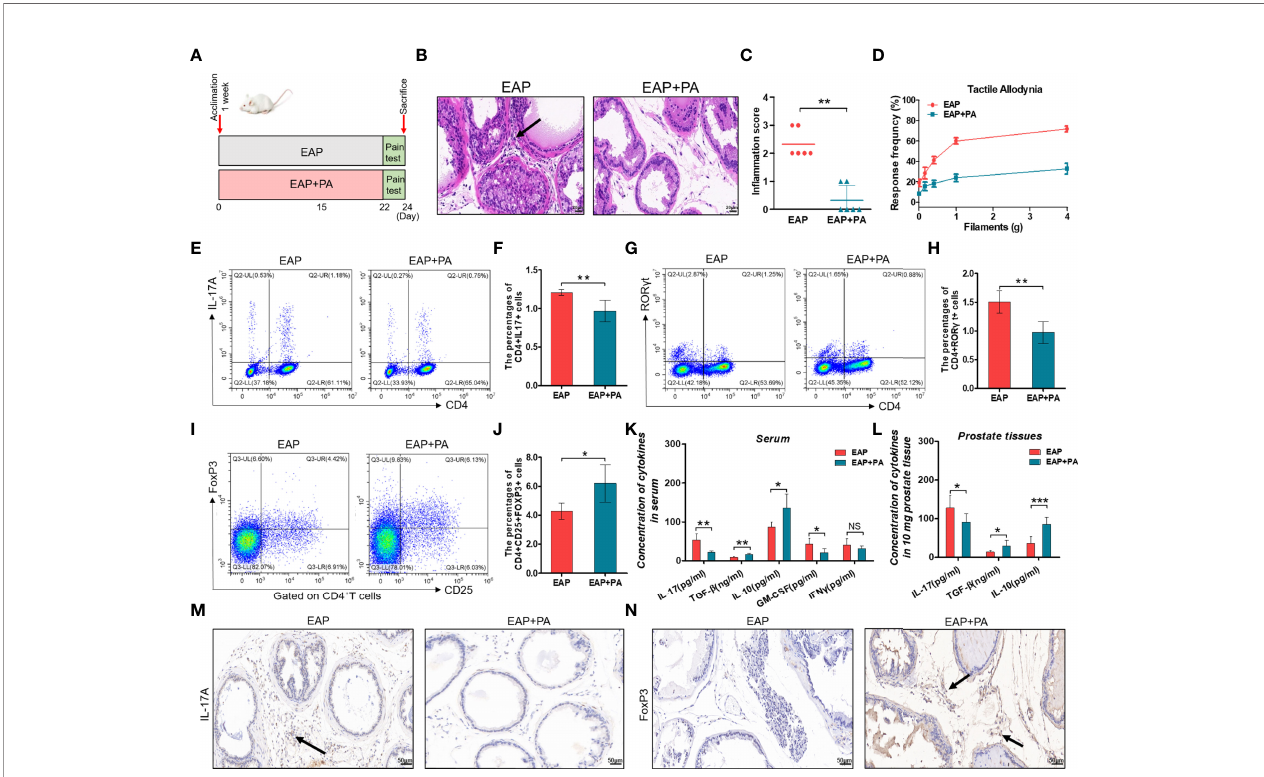
FIGURE 5 | Propionic acid ameliorates EAP and restores Th17/Treg imbalance in vivo. (A) After 1 week of acclimation, all mice received EAP induction. They were divided into an untreated group (EAP group) and a propionate-treated group (EAP+PA group) according to whether propionic acid was added in drinking water or not. Mice were sacri fi ced on day 24 and then samples were collected. (B) Representative HE staining of prostate sections from untreated and propionate-treated EAP mice. The black arrowhead indicates in fi ltration of in fl ammatory cells in the EAP group. (C) In fl ammation score of prostate sections from untreated and propionate-treated EAP mice. (D) Chronic pelvic pain measurement of untreated and propionate-treated EAP mice. (E) Representative pictures of fl ow cytometric staining for CD4 + IL-17 + cells in the splenic lymphocytes from untreated and propionate-treated EAP mice. (F) Flow cytometric analysis of the proportion of CD4 + IL- 17 + cells in untreated and propionate-treated EAP mice. (G) Representative pictures of fl ow cytometric staining for CD4 + ROR g t + cells in the splenic lymphocytes from untreated and propionate-treated EAP mice. (H) Flow cytometric analysis of the proportion of CD4 + ROR g t + cells in untreated and propionate-treated EAP mice. (I) Representative pictures of fl ow cytometric staining for CD4 + CD25 + FoxP3 + cells in the splenic lymphocytes from untreated and propionate-treated EAP mice. (J) Flow cytometric analysis of the proportion of CD4 + CD25 + FoxP3 + cells in untreated and propionate-treated EAP mice. (K) Detection of serum cytokine productions (IL-17, GM-CSF, IFN g , TGF- b , and IL-10) from untreated and propionate-treated EAP mice. (L) Concentration determination of IL-17, TGF- b , and IL-10 in 10 mg of prostate tissue in untreated and propionate-treated EAP mice. (M) Immunohistochemical staining of IL-17A (marker of Th17) on prostate sections in untreated and propionate-treated EAP mice. (N) Immunohistochemical staining of FoxP3 (marker of Treg) on prostate sections in untreated and propionate-treated EAP mice. The black arrows indicate the IL-17/FoxP3-positive cells in the two groups. Data are from one experiment representative of three independent experiments. Data are representative of three independent experiments. n = 5 – 6/group; * p < 0.05; ** p < 0.01; *** p < 0.001; NS, not signi fi cant; EAP, experimental autoimmune prostatitis; HE, hematoxylin – eosin, PA, propionic acid; IL-17, interleukin-17; ROR g t, retinoic acid − related orphan receptor g t; GM-CSF, granulocyte-macrophage colony stimulating factor; IFN g , interferon gamma; TGF- b , transforming growth factor- b ; IL-10, interleukin-10; FoxP3, forkhead box P3; Treg, regulatory T